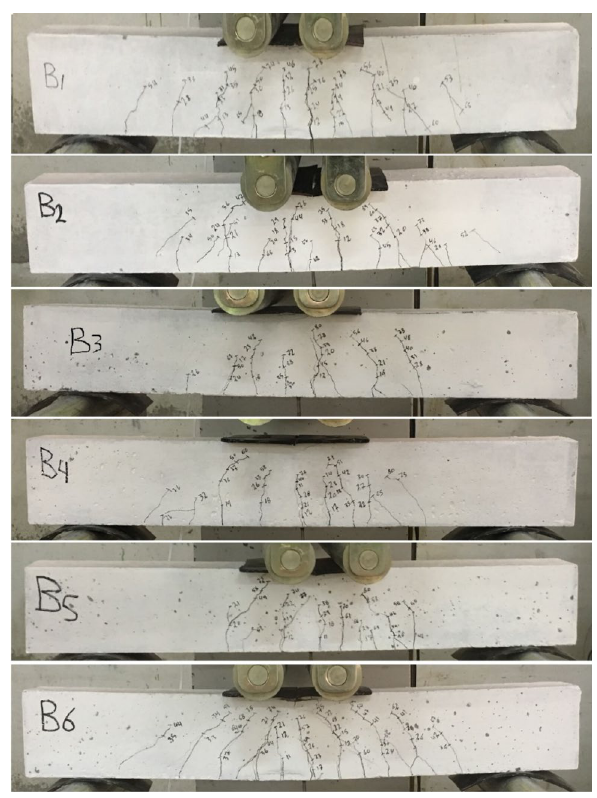
Fig. 4 Cracks at the failure of the tested